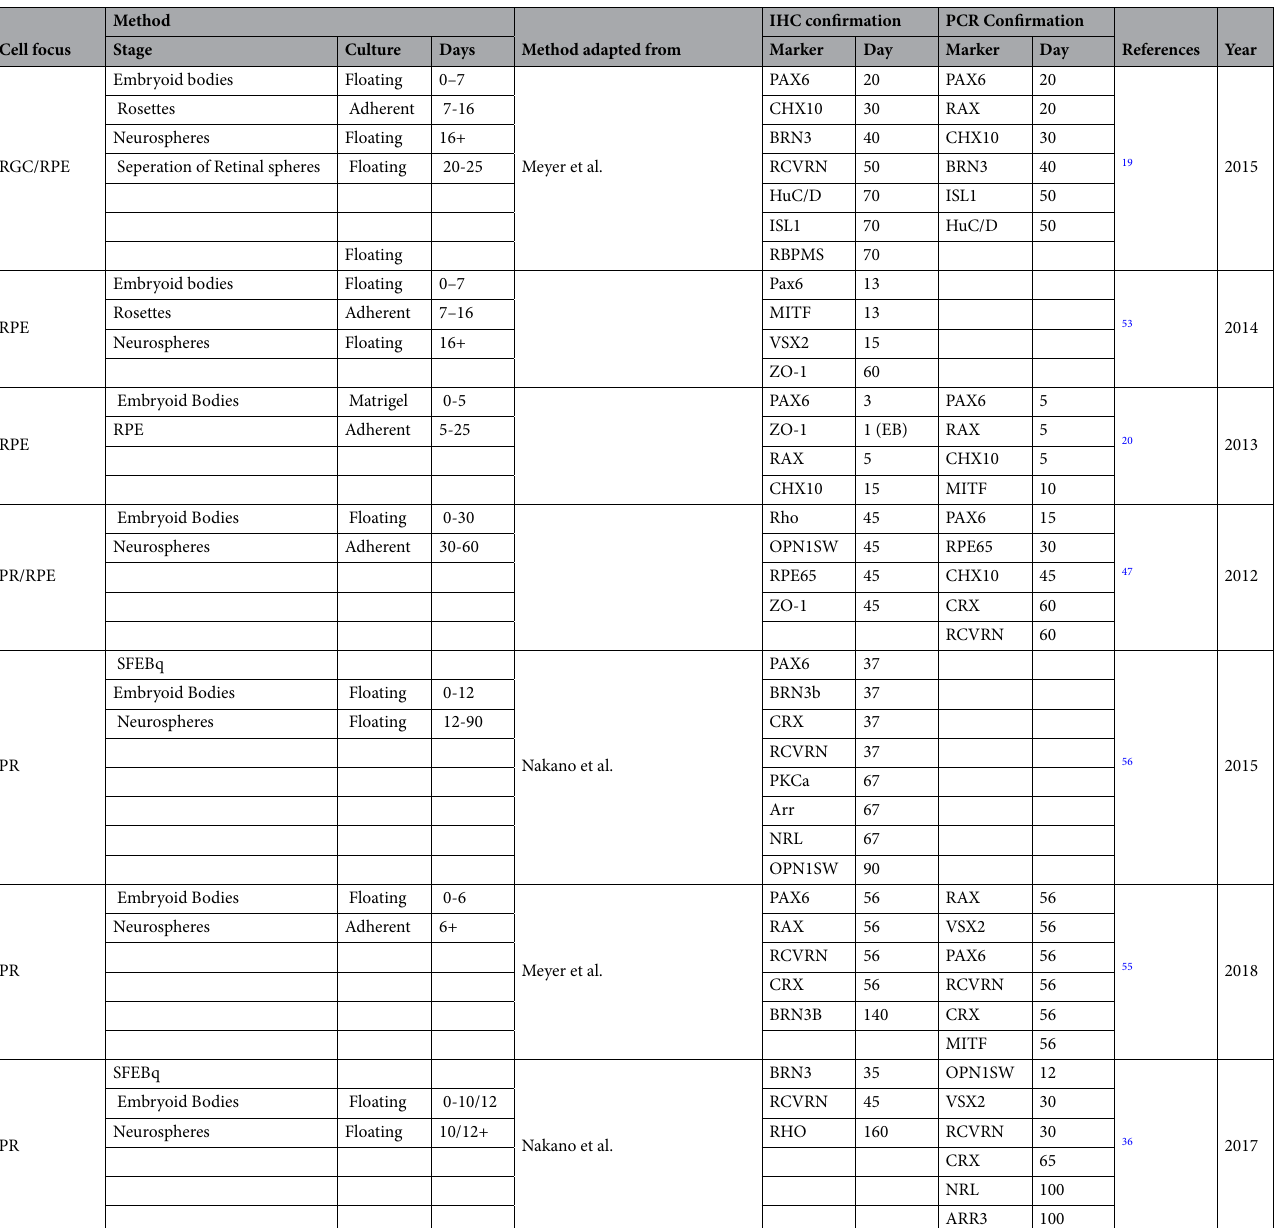
Table 1. A comparison of popular retinal differentiation protocols against our MG/FF combination protocol, showing the expression timeline of specific cell markers used to confirm the generation of general